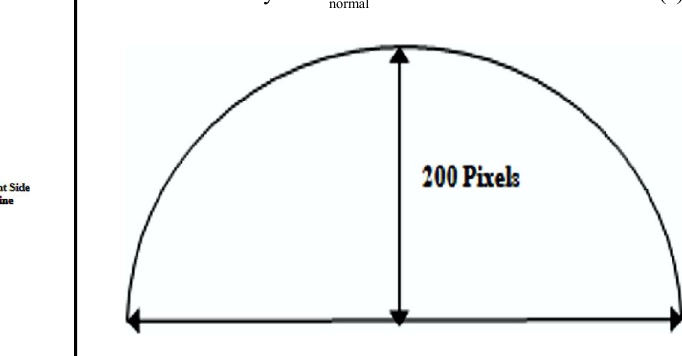
FIG. 11. DIAGRAM TO SHOW THE RANGE OF THE BORDER